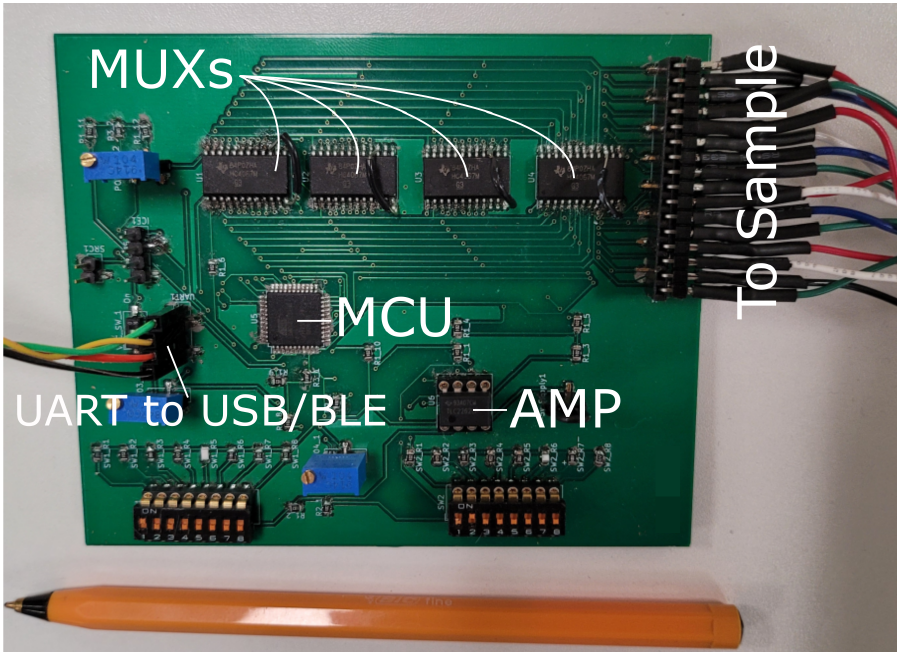
Figure 6. PCB of final ConcrEITS circuit with addressing wires. A UART to USB or UART to BLE module is used for data